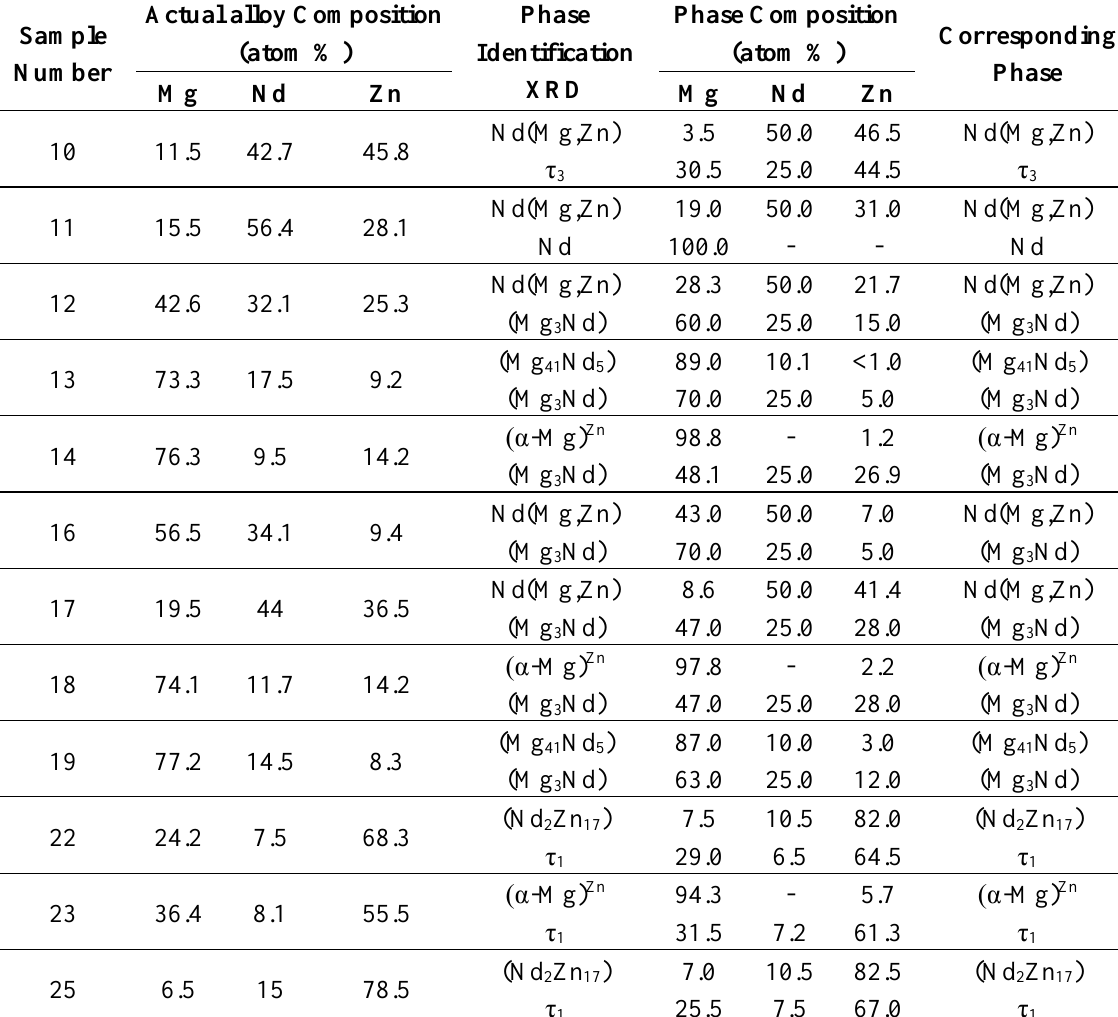
Table 4. Actual composition of key alloys containing two-phase equilibria and their experimental